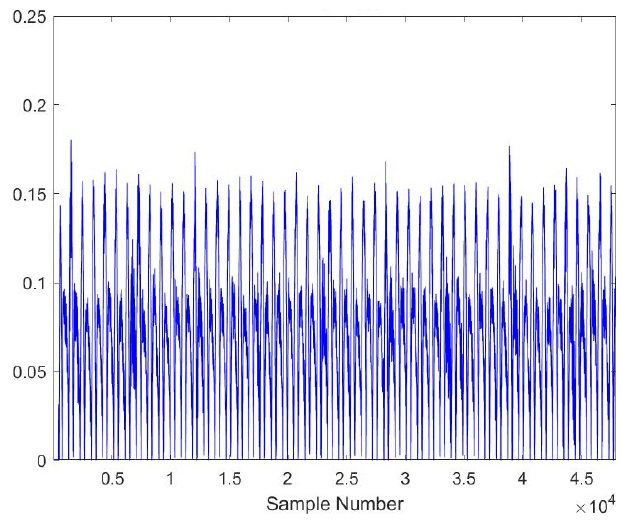
Figure 9. RMS plot of Softwood, New Tool, 1 mm depth-of-cut.